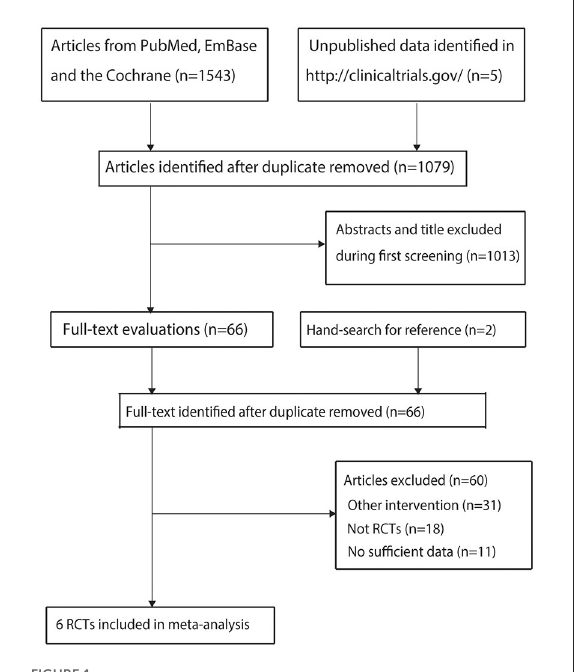
FIGURE1 PRISMA flowchart with details of the literature search and study